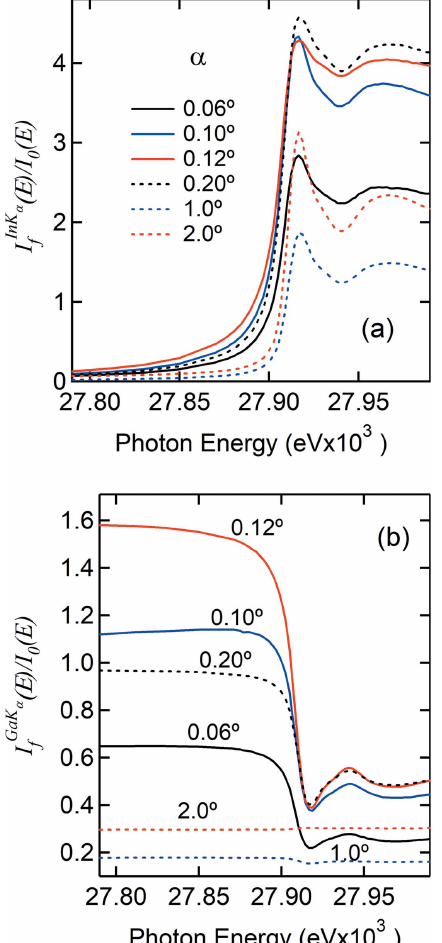
Figure 2 Raw In K (cid:5) spectra ( a ) and raw Ga K (cid:5) spectra ( b ) as a function of the X-ray incidence angle (cid:5) , measured simultaneously while the X-ray energy scans across the In K -edge.